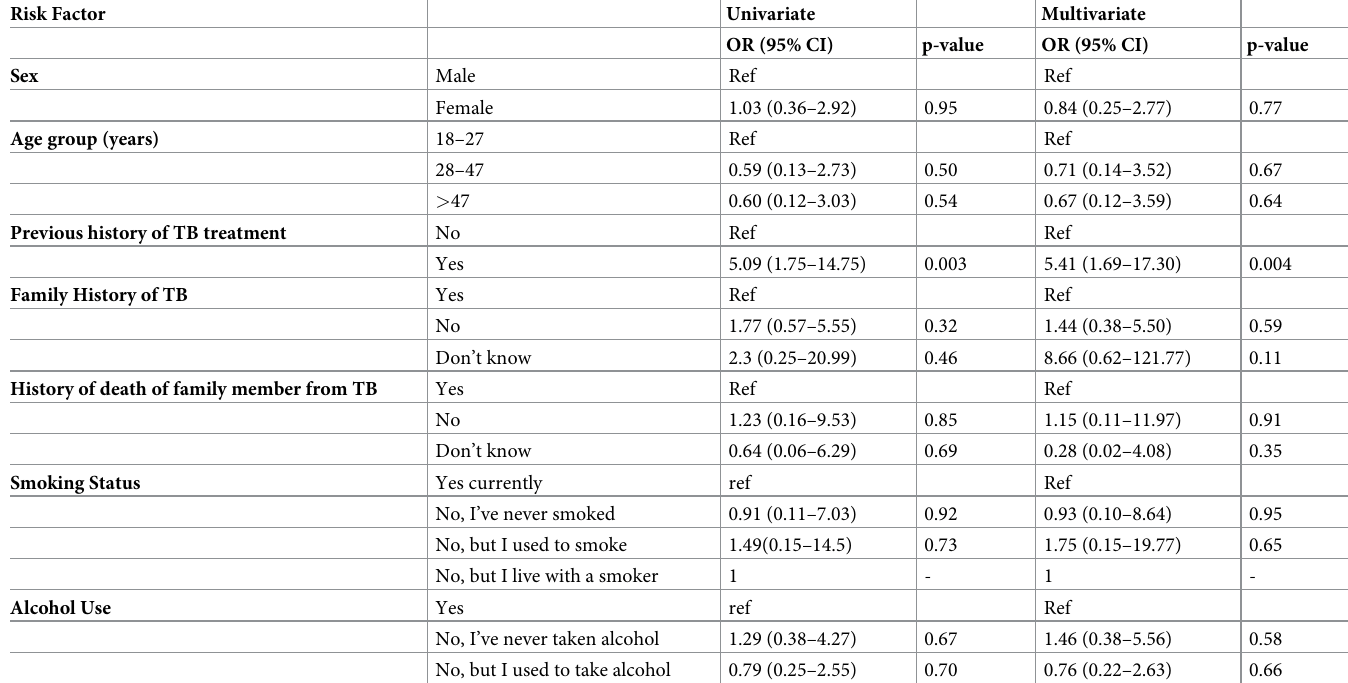
Table 3. Risk factors for drug resistance TB in